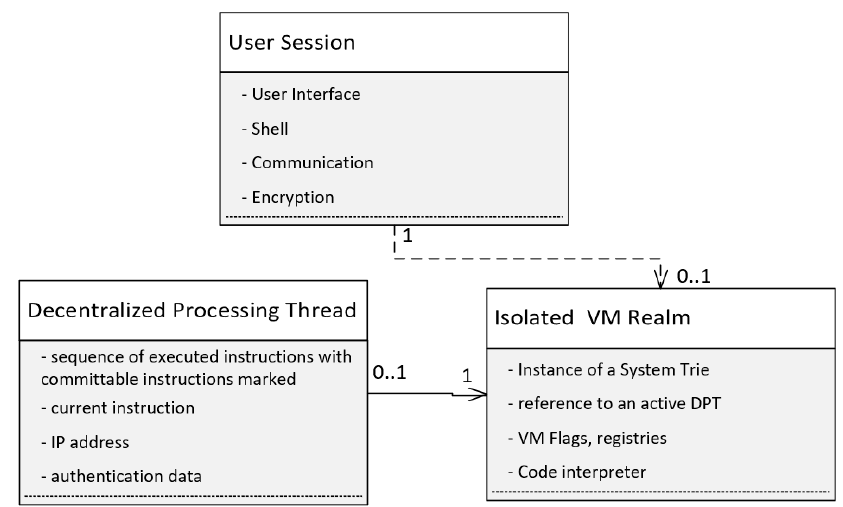
Figure 10. Relationship between User Session, Decentralized Processing Threads, and Isolated VM Realms.